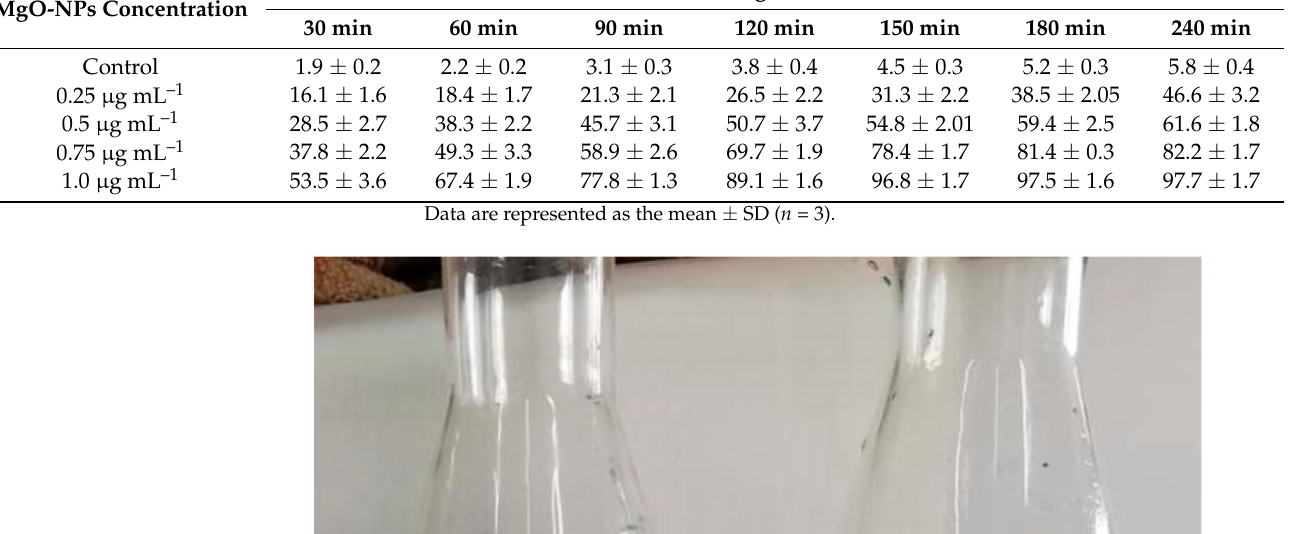
Table 1. Decolorization percentages (%) of tanning effluent using different concentrations (0.25, 0.5, 0.75, and 1.0 µ g mL − 1 ) of myco-synthesized MgO-NPs at different contact times (30, 60, 90, 120, 150, 180, and 240 min). Decolorization Percentages (%) after the Time (min) MgO-NPs Concentration